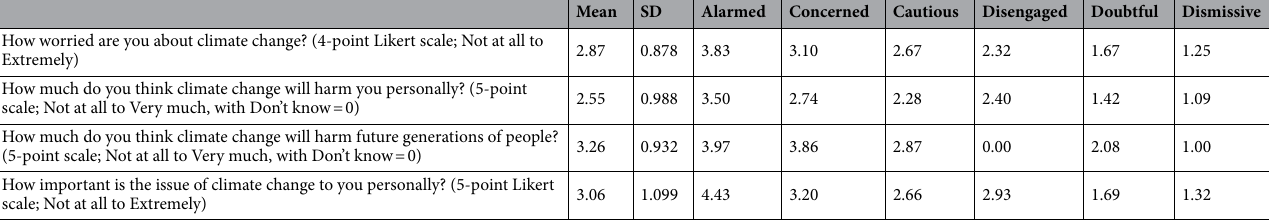
Table 1. Descriptive statistics of climate change beliefs and concern across the segments. N = 1051. Table presents mean values of key variables across the